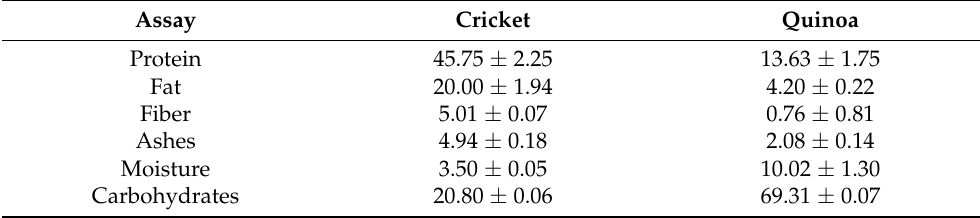
Table 1. Proximal composition of flour ( Gryllus assimilis ) and quinoa flour. Calculated by ratio g/100 g dry matter. Assay Cricket Quinoa Protein 45.75 ± 2.25 13.63 ± 1.75 Fat 20.00 ± 1.94 Fiber Ashes Moisture